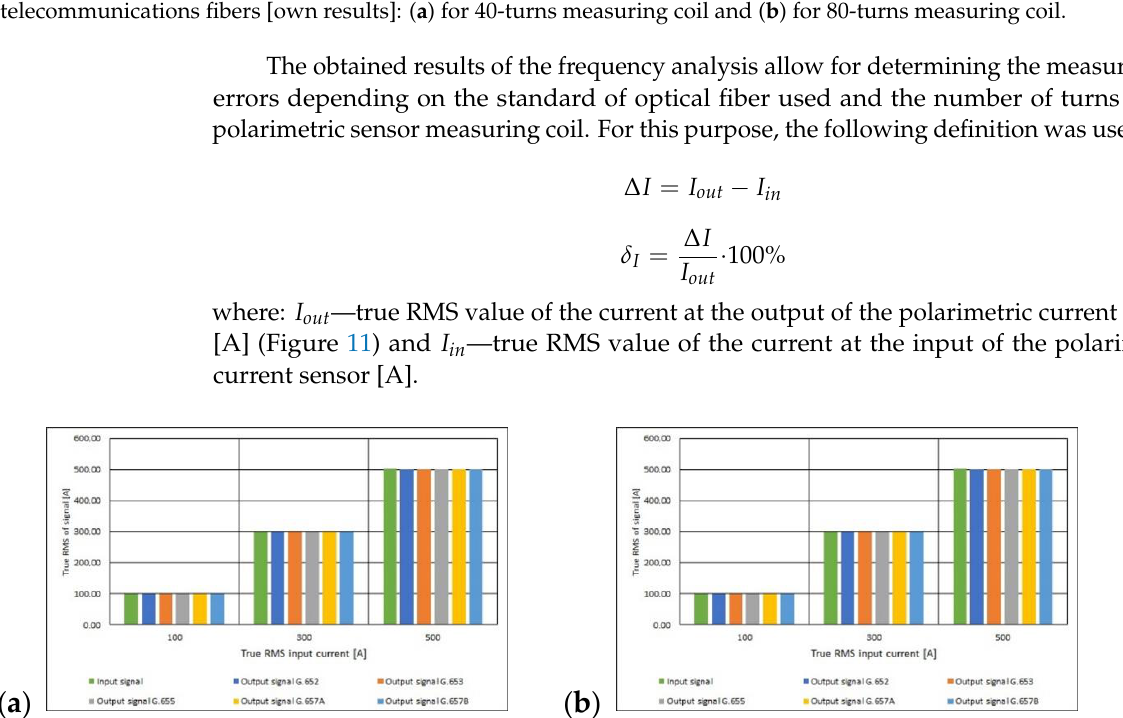
Figure 11. Values of True RMS of measuring current for polarimetric current sensor with measuring coil made of the different standards of single mode telecommunications fibers [own results]: ( a ) for 40-turns measuring coil and ( b ) for 80-turns measuring coil.